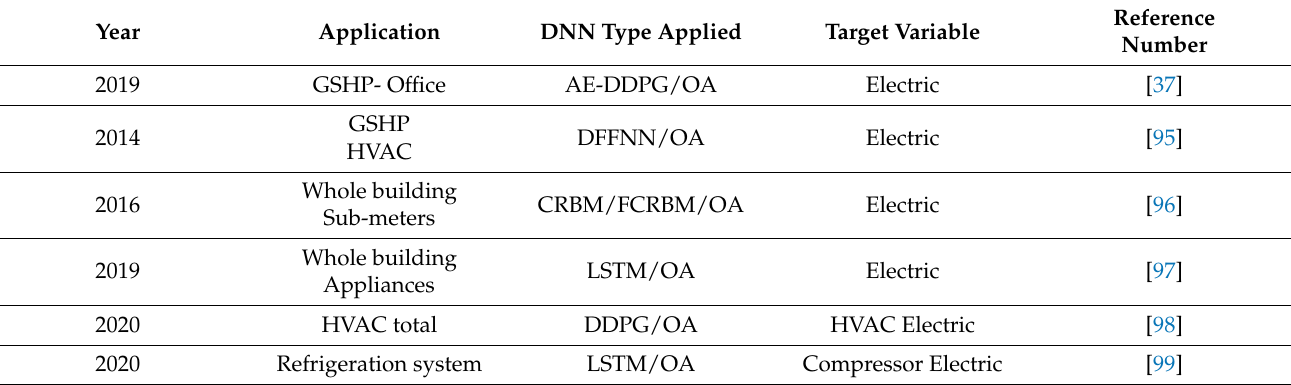
Table A3. Sub-meter and component-level DL